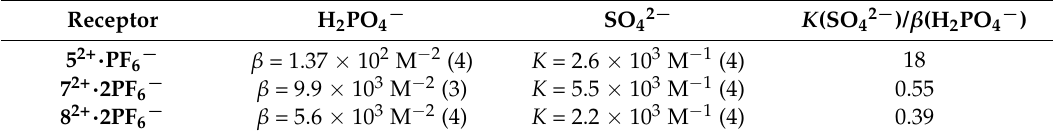
Table 2. Association constants for receptors 5 2+ · 2PF 6 − , 7 2+ · 2PF 6 − and 8 2+ · 2PF 6 − with H 2 PO 4 − and SO 42 − anions in CD 3 CN/CD 3 OD 8:2 v / v measured using the 1 H-NMR technique. Errors (in percent) are given in